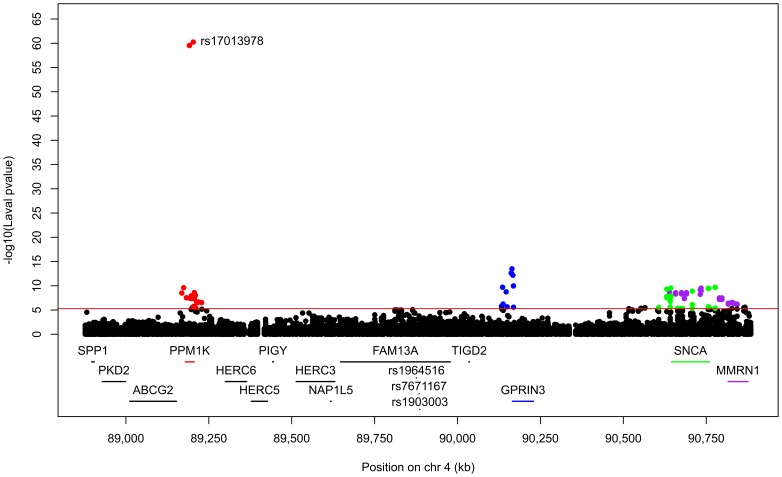
Lung eQTLs on 4q22 in the Laval dataset.Each dot represents an association test between one SNP and one probeset. Only dots above the red line are significant (p<5.10×10−6). Significant SNPs were regulating the expression levels of PPM1K in red, GPRIN3 in blue, SNCA in green and MMRN1 in purple. The SNP with the smaller p-value is indicated. SNPs previously associated with COPD are presented at the bottom.